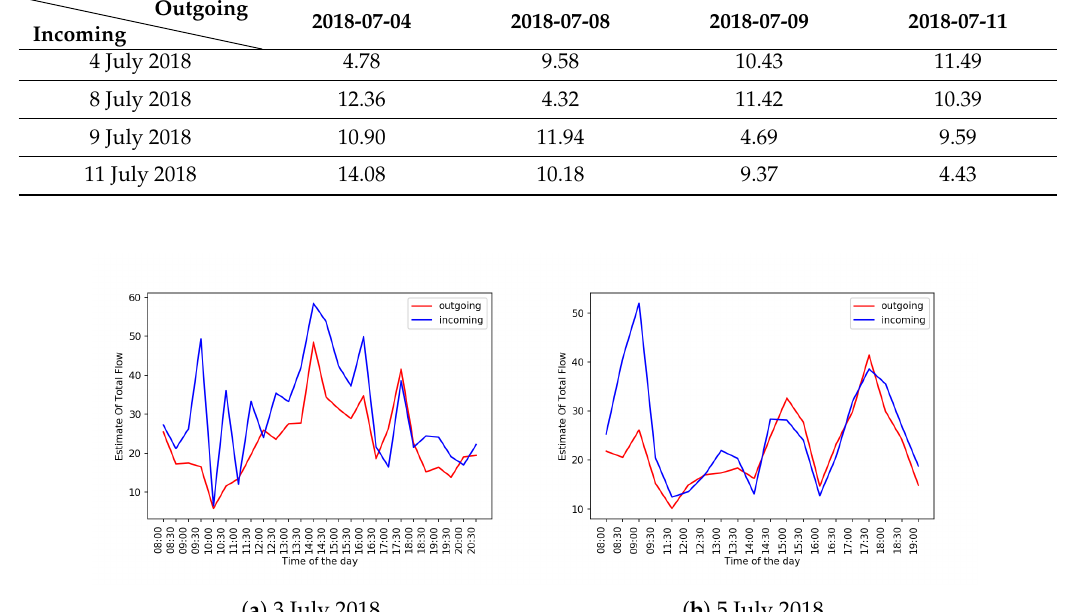
Figure 11. Plots of I v and O v values for 3 July 2018 and 5 July 2018. DTW similarity of the curves on 3 July is 12.436; DTW similarity of the curves on 5 July is